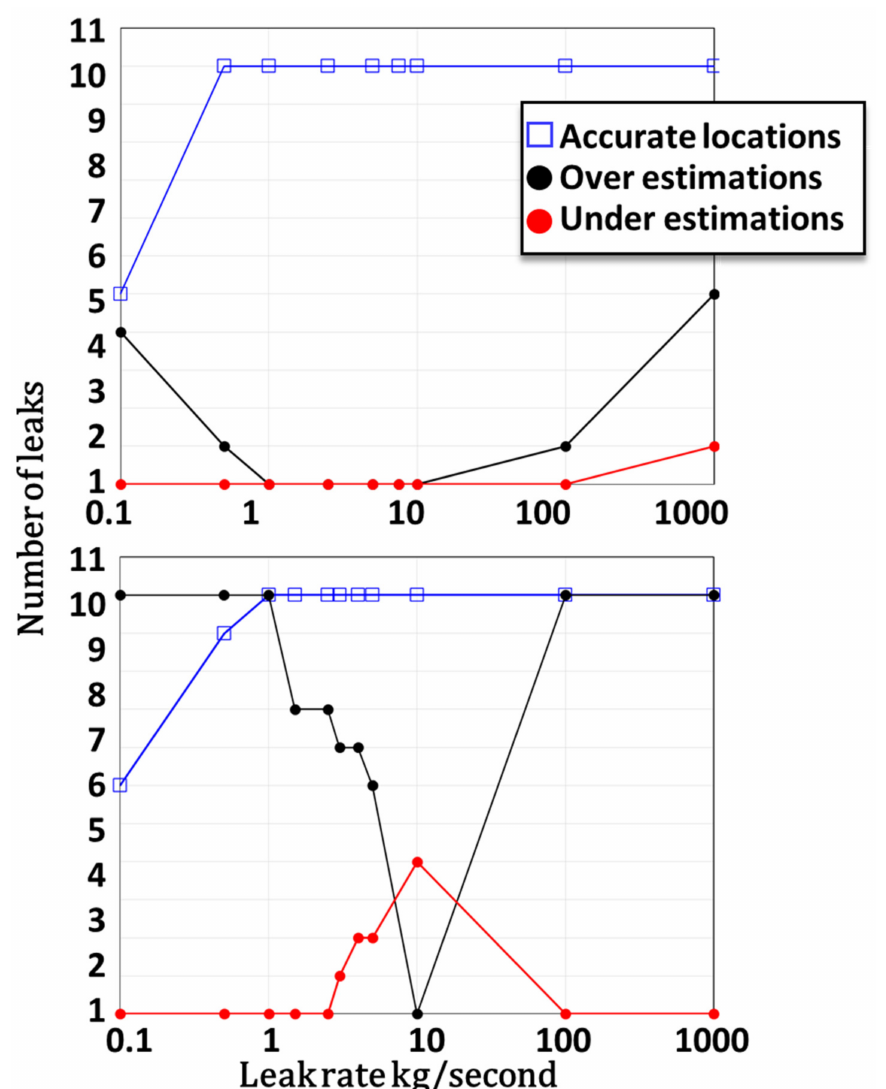
Figure 6. ( Top ): number of accurate leak locations (blue squares), number of overestimated leaks (black dots), and number of underestimated leaks (red dots) as a function of the leak rate for a six-detector array with an MDL of 3 kg/m 3 and a DR of 30. ( Bottom ): same for a six-detector array with an MDL of 3 kg/m 3 and a DR of 1 (binary detector